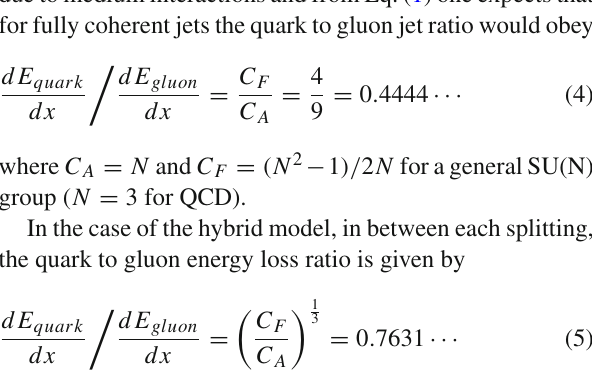
Fig. 2 R (Δ p T ) v ac + med as a function of the initial parton p